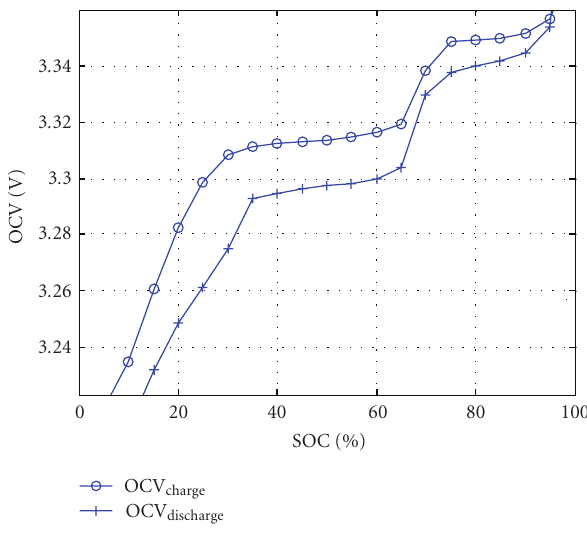
Figure 4: OCV after 3 hours rest plotted over the SOC, after stepwise discharging and charging with 0.5C.